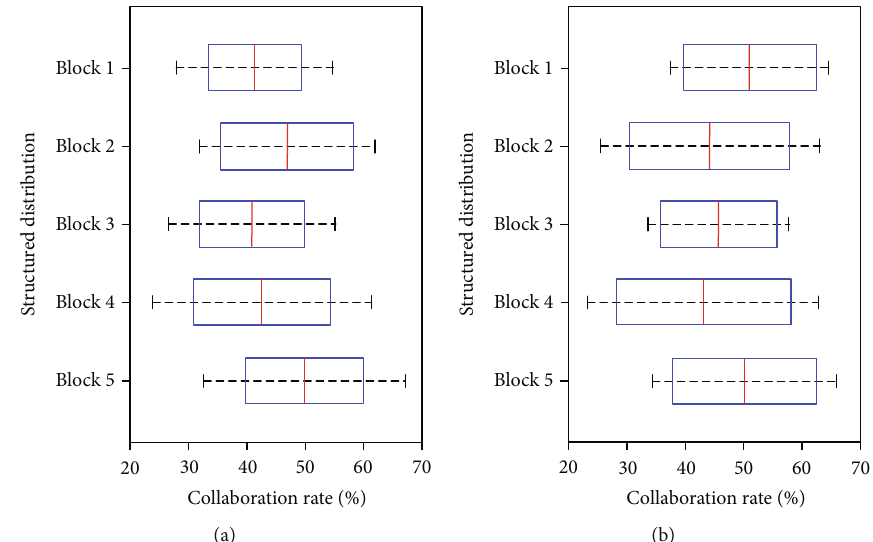
Figure 5: Data security sharing and access control mechanism in public administration (a) and resource allocation (b) based on blockchain and structured occupational